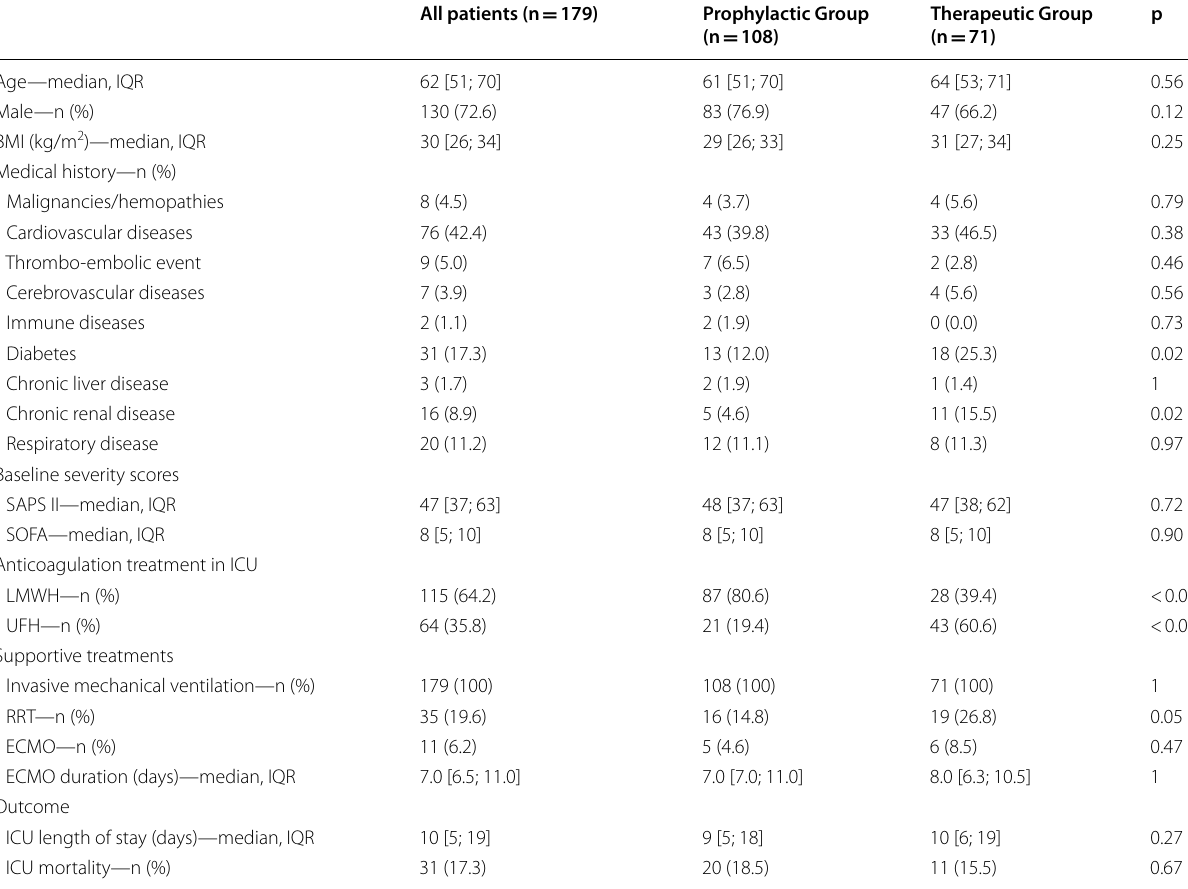
Table 1 Characteristics of COVID-19